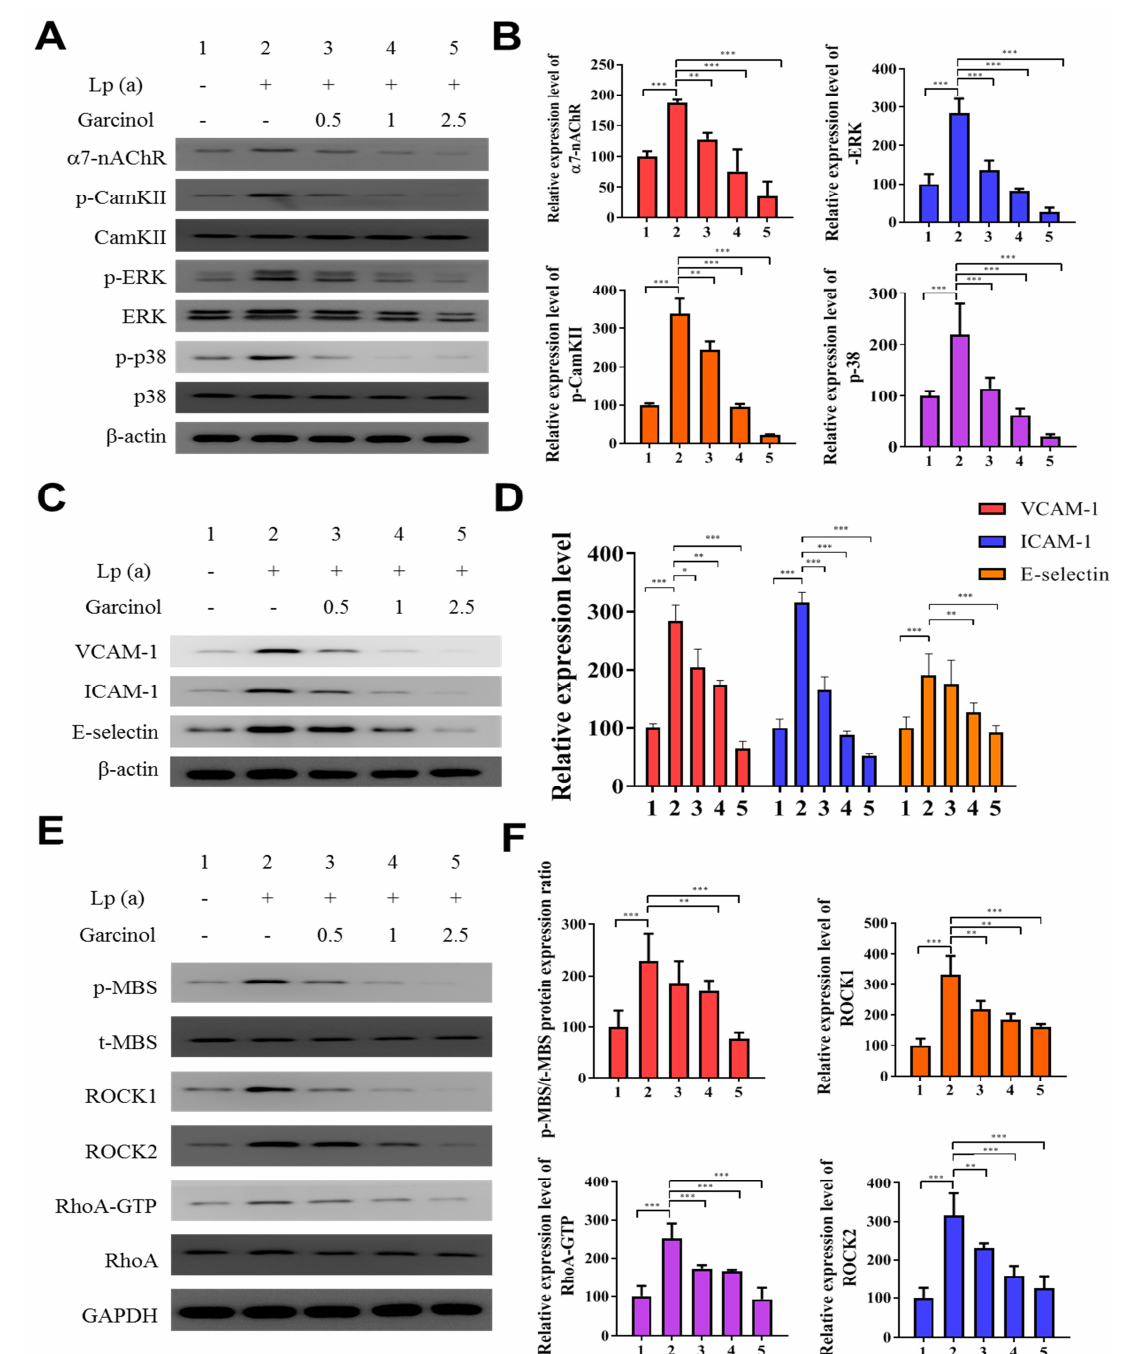
Figure 3 Figure 3. Garcinol inhibited the α 7-nAChR-mediated phosphorylation and expression of adhesion molecules as well as RhoA-GTP activity in cardiomyocyte AC16 cells. ( A ) Western blot analysis showed that garcinol dose-dependently decreased the Lp(a)-induced activation of α 7-nAChR and phosphorylation of CamKII, p38 MAPK and ERK. ( B ) Densitometry analysis of the immunoblots, shown as bar graphs normalized to β -actin. ( C ) Representative image of Western blot and ( D ) quantitative real-time polymerase chain reaction (qRT-PCR) mRNA analysis showing the dose-dependent reduction of Lp(a)-induced vascular cell adhesion molecule 1 (VCAM-1), intercellular adhesion molecule 1 (ICAM-1), and E-selectin expression by garcinol. ( E ) and ( F ) The Lp(a)-induced activation of the RhoA-GTP/Rho-kinases (ROCK1, ROCK2) were dose-dependently decreased by garcinol. * p < 0.05, ** p < 0.01, *** p <